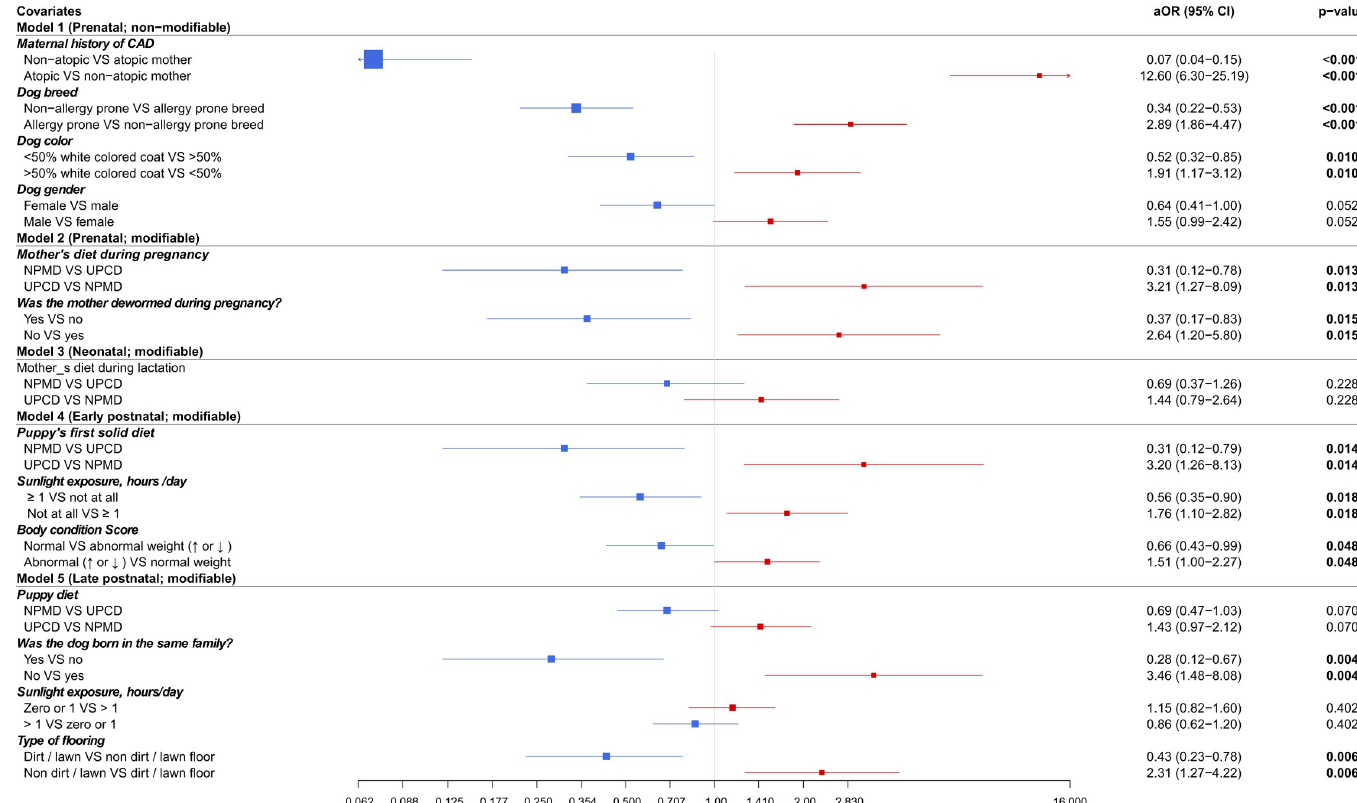
Fig 4. Forest plot of odds ratios for associations between pre-, neo-, early post- and late postnatal period variables and canine atopic dermatitis based on multivariable logistic regression analyses (n = 2236). Included/missing dogs for each model: model 1 (789/1447), model 2 (1357/879), model 3 (1297/939), model 4 (782/ 1454) and model 5 (1071/1165). Models 2–4 have been adjusted for dog gender. aOR: adjusted odds ratio, CI: confidence interval, CAD: canine atopic dermatitis, bolded: P � 0.05, NPMD: non-processed meat based diet, UPCD: ultra-processed carbohydrate based diet, VS: versus.